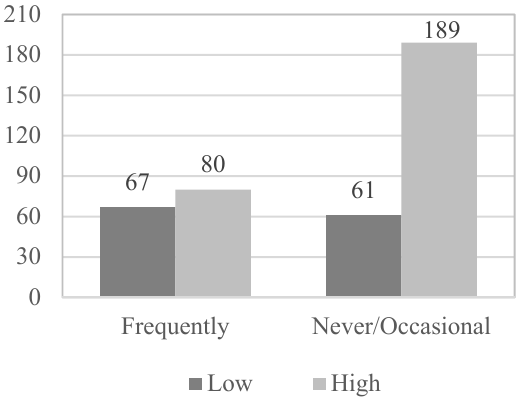
Figure 4. Use of social and health services_Health satisfaction.